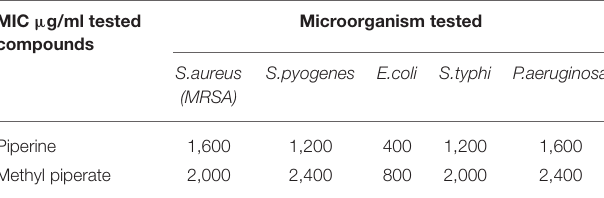
TABLE 3 | Antibacterial activity of piperine and methyl